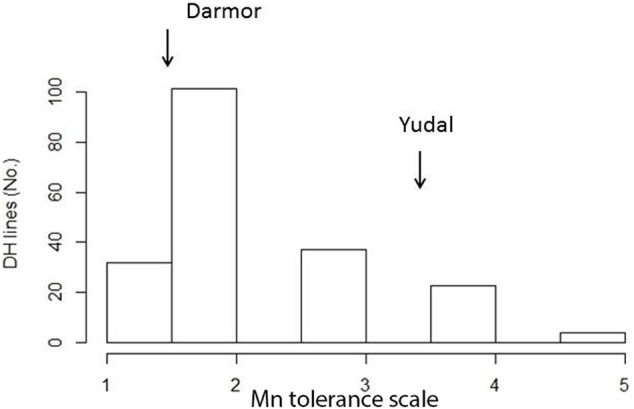
Frequency distribution of Mn2+ tolerance scores in the doubled haploid mapping population derived from an F1 cross between Darmor-bzh and Yudal (DYDH). The phenotypic scores based on the extent of chlorosis of parental lines, Darmor-bzh and Yudal are marked with inverted arrows.